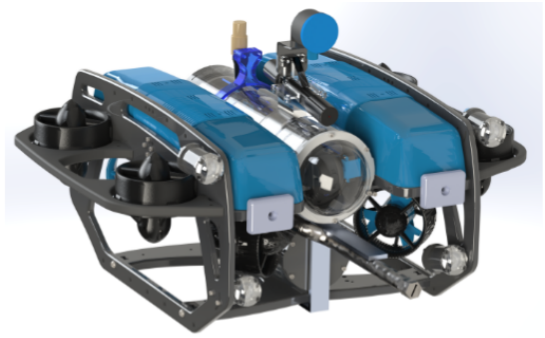
Figure 1. BlueROV2 with modification designed for cleaning